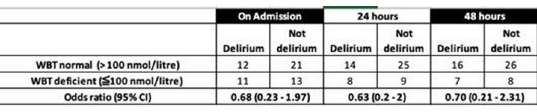
Table 1. Relationship between WBT on ICU admission, t‑24 h, t‑48 h and delirium occurrence in ICU.